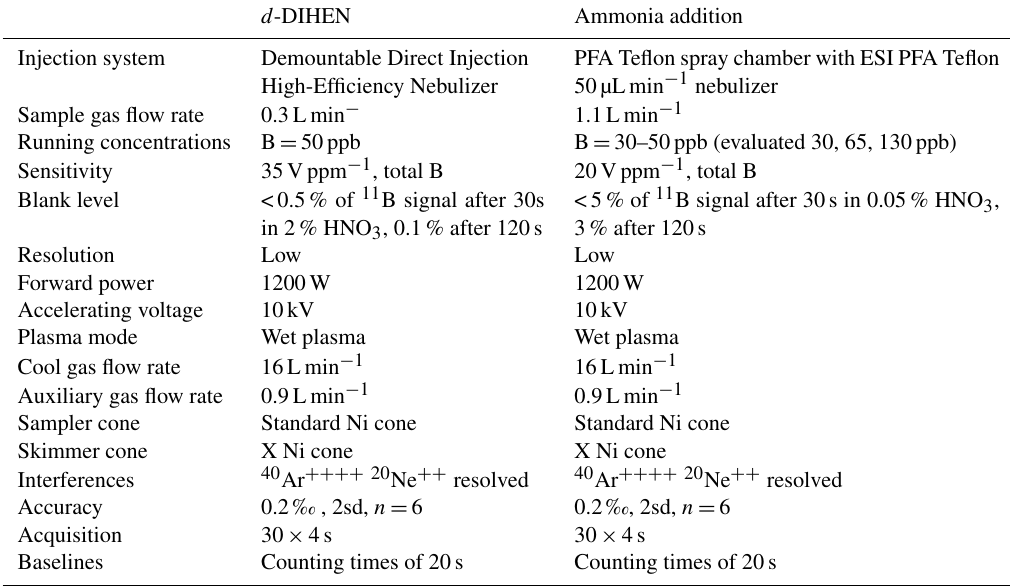
Table 2. Mass spectrometer operating